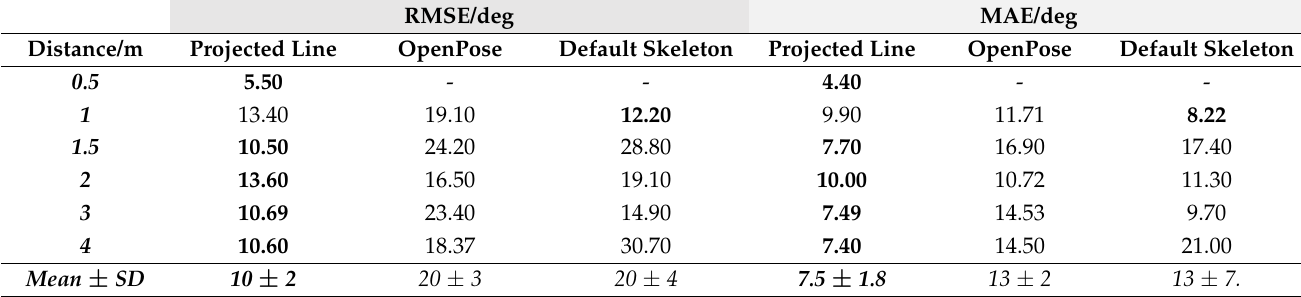
Table 3. In distance tests, error values obtained by the projection lines method based on Mask RCNN proposed in this work, OpenPose software and the Kinect default skeleton, versus the IMUs gold